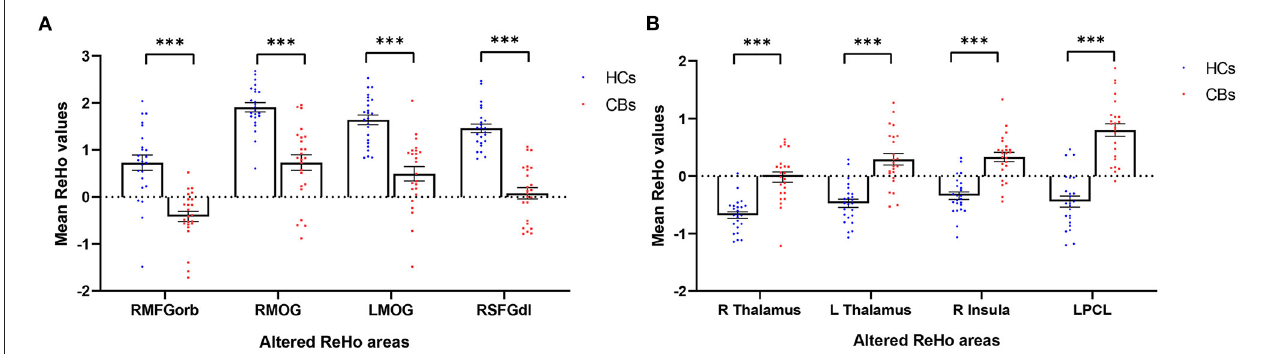
FIGURE 2 | Mean ReHo values (Z-score) of significantly altered brain areas between the CB and HC groups. (A) Compared to HCs, The mean ReHo values of the following regions were decreased in CB patients: RMFGorb ( t = − 5.62), the RMOG ( t = − 5.96), LMOG ( t = − 5.94), and the RSFGdl ( t = − 8.75). (B) Compared to HCs, the mean ReHo values of the following regions were increased in CB patients: the R Thalamus ( t = 5.98), the L Thalamus ( t = 6.23), the R insula ( t = 6.2), the LPCL ( t = 8.21).ReHo, regional homogeneity; CB, congenital blindness; HC, healthy control; R, right; L, left; RMFGorb, right orbital part of middle frontal gyrus; RMOG, right middle occipital gyrus; LMOG, left middle occipital gyrus; RSFGdl, right dorsolateral superior frontal gyrus; LPCL, left paracentral lobule. ***Represents the significant differences in ReHo value between the two groups ( p < 0.001).